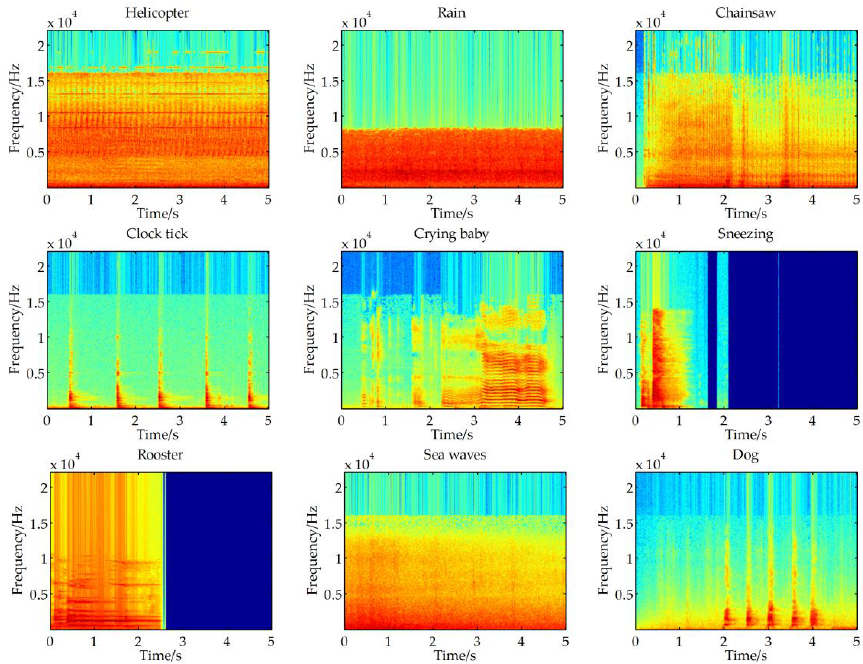
Figure 1. The spectrograms of different types of sound signal examples in the ESC-10 dataset. The spectrogram can reflect at the same time the change of frequency and amplitude of the signal with time. A set of sound classification features based on perception and statistical analysis are proposed by visualizing and analyzing the time domain waveform and spectrograms of the audio signal. The proposed new feature is the signal analysis (SA) feature. This feature consists of the continuous frame correlation feature, the signal posi- tive and negative waveform amplitude similarity feature, the average amplitude feature of energy fluctuations in the time domain, and the adjacent frame correlation feature, the sub-band energy fluctuation amplitude feature in the frequency domain. The features are extracted from the time domain and frequency spectrum, adjacent frames, and sub-bands. Then, existing features including sub-band energy distribution ratio, spectral entropy, cross entropy, and the short-time energy in the time domain, ZCR, and MFCC are com- bined to form a JSA feature. 2.1. Signal Analysis (SA) Feature The proposed features in SA will be described in detail in this section. 2.1.1. Time Domain Feature Signal time domain features generally do not require a formal transformation of the original audio signal, processed on the sampled values of the signal itself. Based on the time domain waveform analysis of audio signals, the continuous frame correlation feature, the signal positive and negative waveform amplitude similarity feature, and the time do- main signal energy fluctuation rate feature are proposed. Assume that x represents the signal time domain amplitude, N represents the frame length of each signal frame, k de- notes the index value of the number of frames, and K is the total number of frames. The continuous frame correlation feature is expressed as: